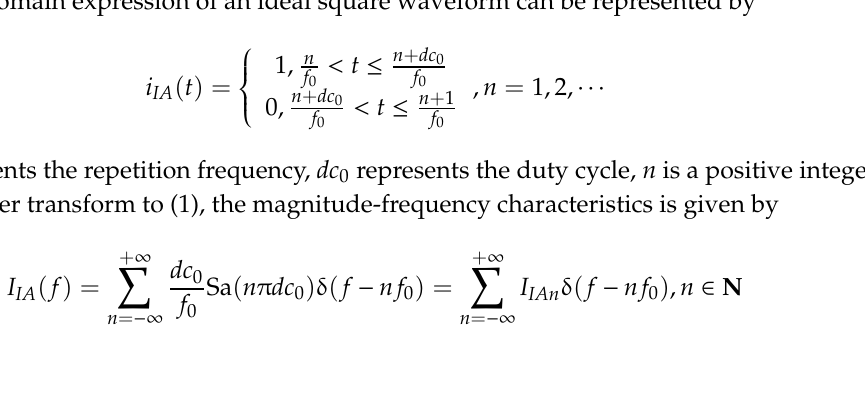
Figure 4. IC conducted emission model partitioning. ICIA and ICPDN.